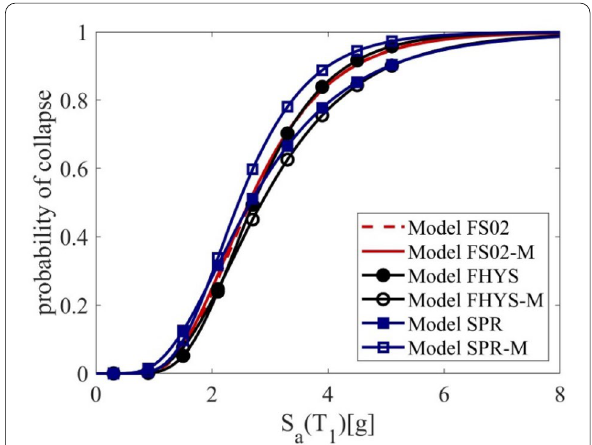
Fig. 14 Collapse fragility functions for all modeling choices based on IDA and GM Set